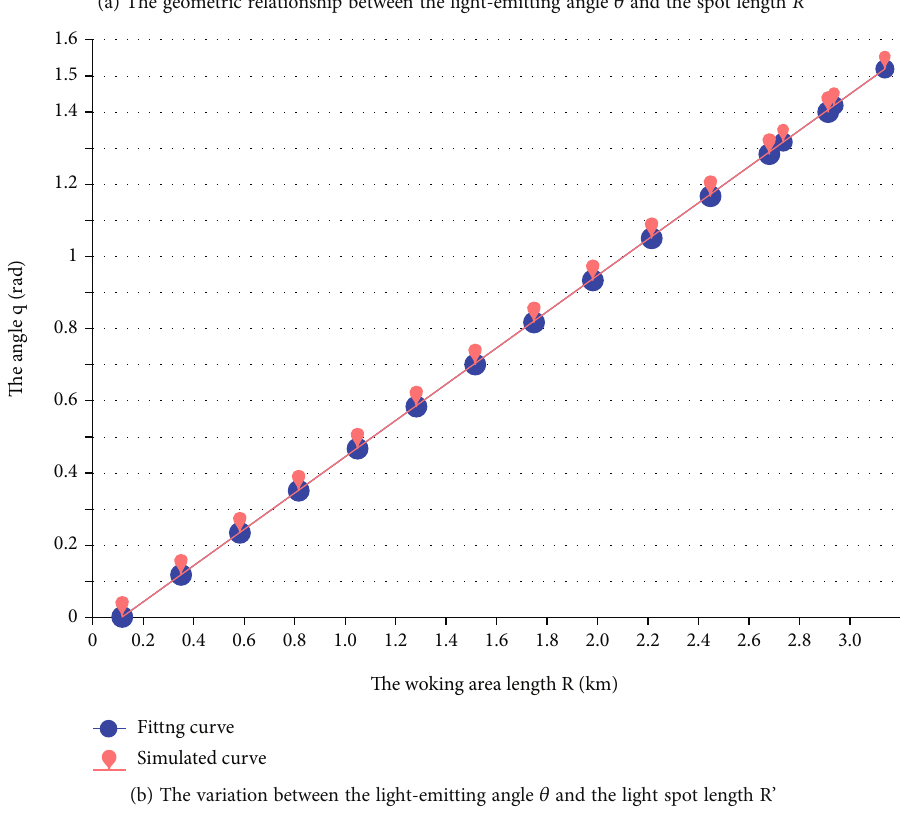
Figure 3: Simulation of luminous